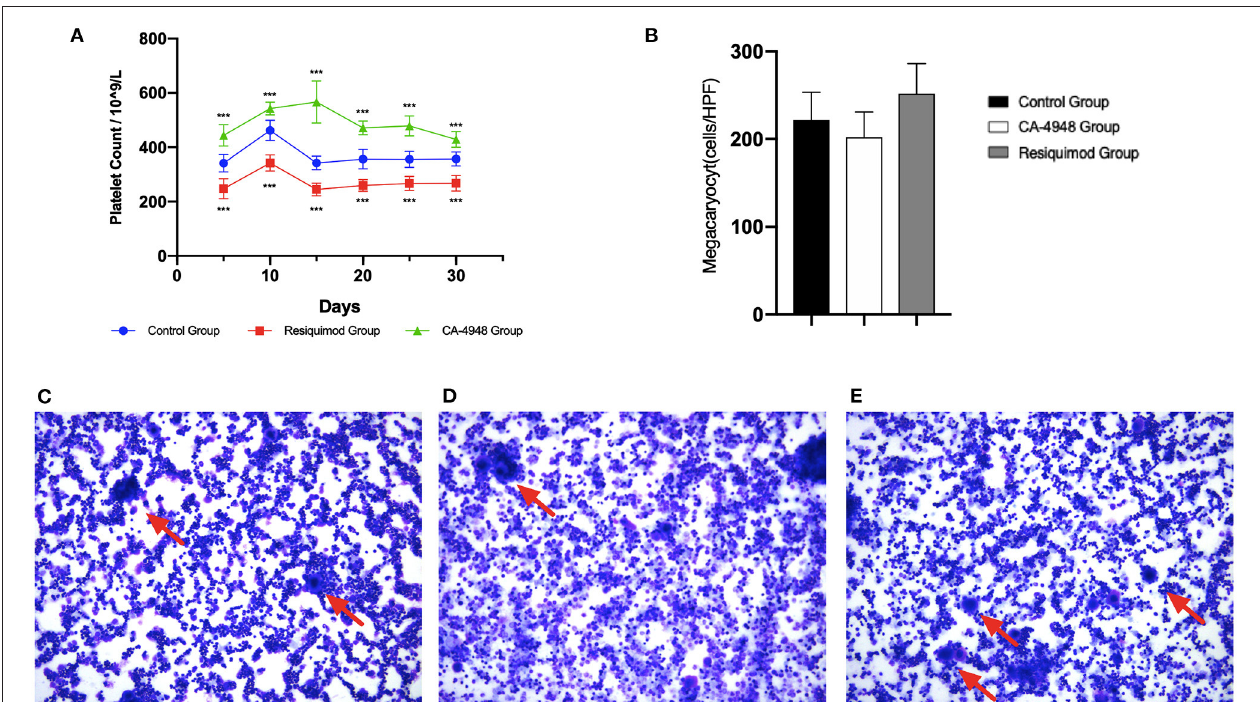
FIGURE 4 | Effects of Tol-like Receptor (TLR) pathway activation or inhibition on platelet and megakaryocyte in bone marrow in Non-obese diabetic (NOD) mice. (A) Platelet counts changes after CA-4948 ( n = 8)/Resiquimod ( n = 8)/saline ( n = 8) treatment in NOD mice. After 5 days of treatment, consistent significant increase of platelet counts were observed in the CA-4948 group compared with the ones in the control group. (B) Megakaryocyte (MK) counts after CA-4948/Resiquimod/saline treatment in NOD mice. (C) MK morphology in control group. (D) MK morphology in CA-4948 group. (E) MK morphology in Resiquimod group. More naked nucleus MK were observed in the Resiquimod group, although without statistical significance. Red Arrow, MK (*** p <